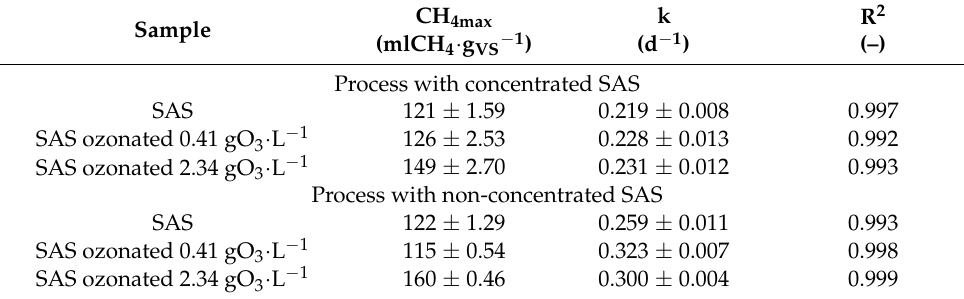
Figure 5. Methane production during the process with non ‐ concentrated SAS—fitting to the first order model. Table 4. Kinetic parameters obtained for methane